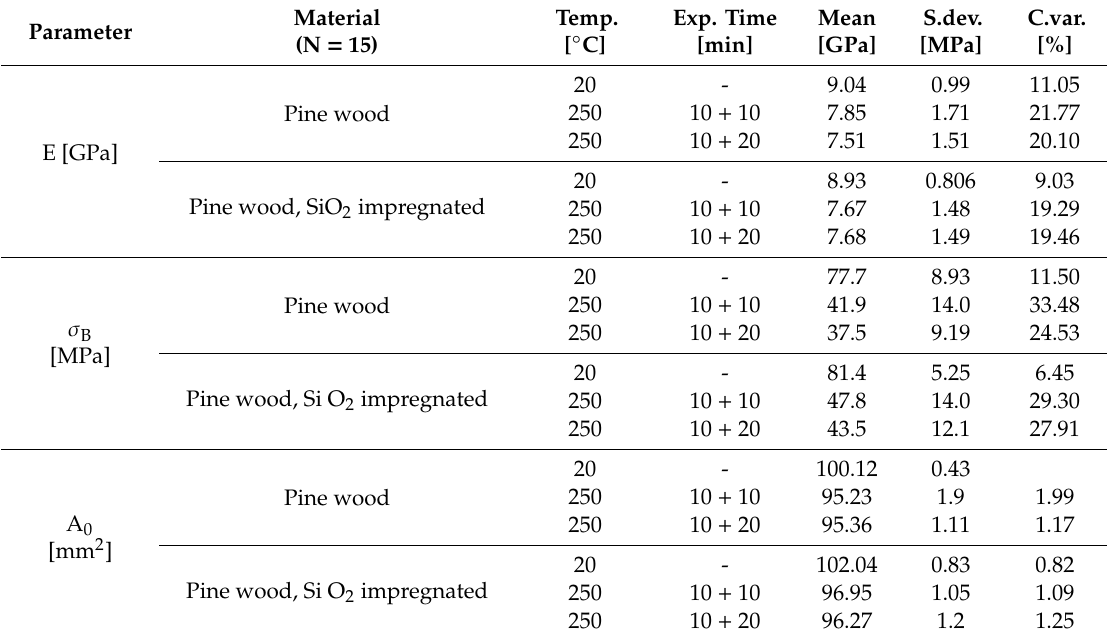
Table 2. Statistics of the four-point bending strength test